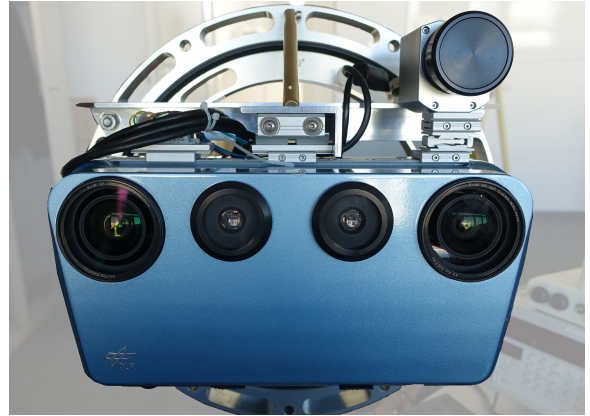
Figure 3. Stereo-Camera system with long-wave infrared camera attached on top. The system is mounted on a rotary plate for calibration purposes.